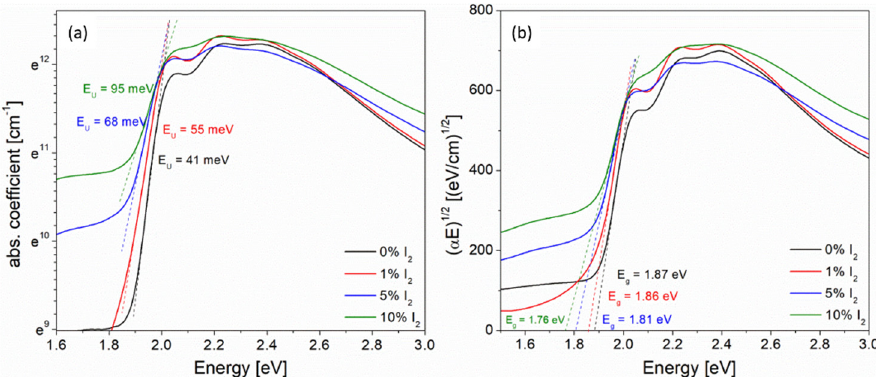
Figure 2. Absorption edges of iodine-doped P3HT thin films, used to obtain ( a ) the Urbach energy ( b ) the energy gap.